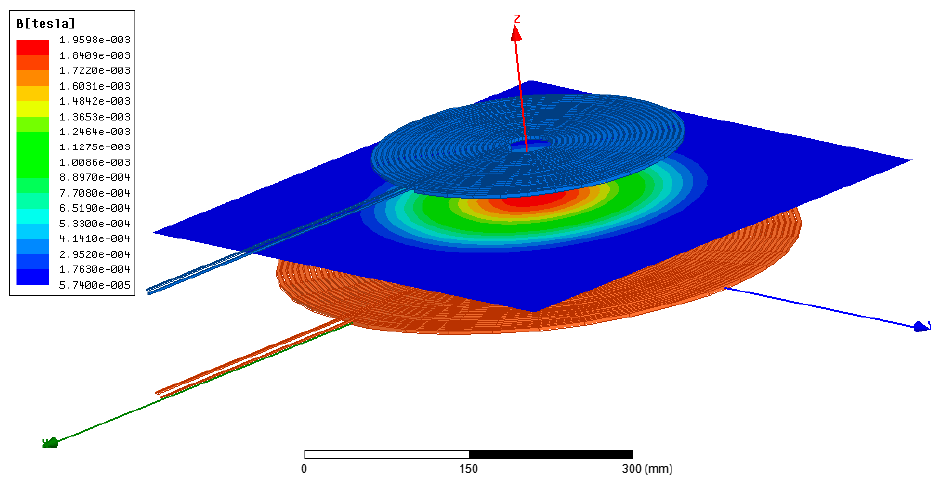
Figure 19. Magnetic field distribution of the pair of coils Coil1–Coil2.